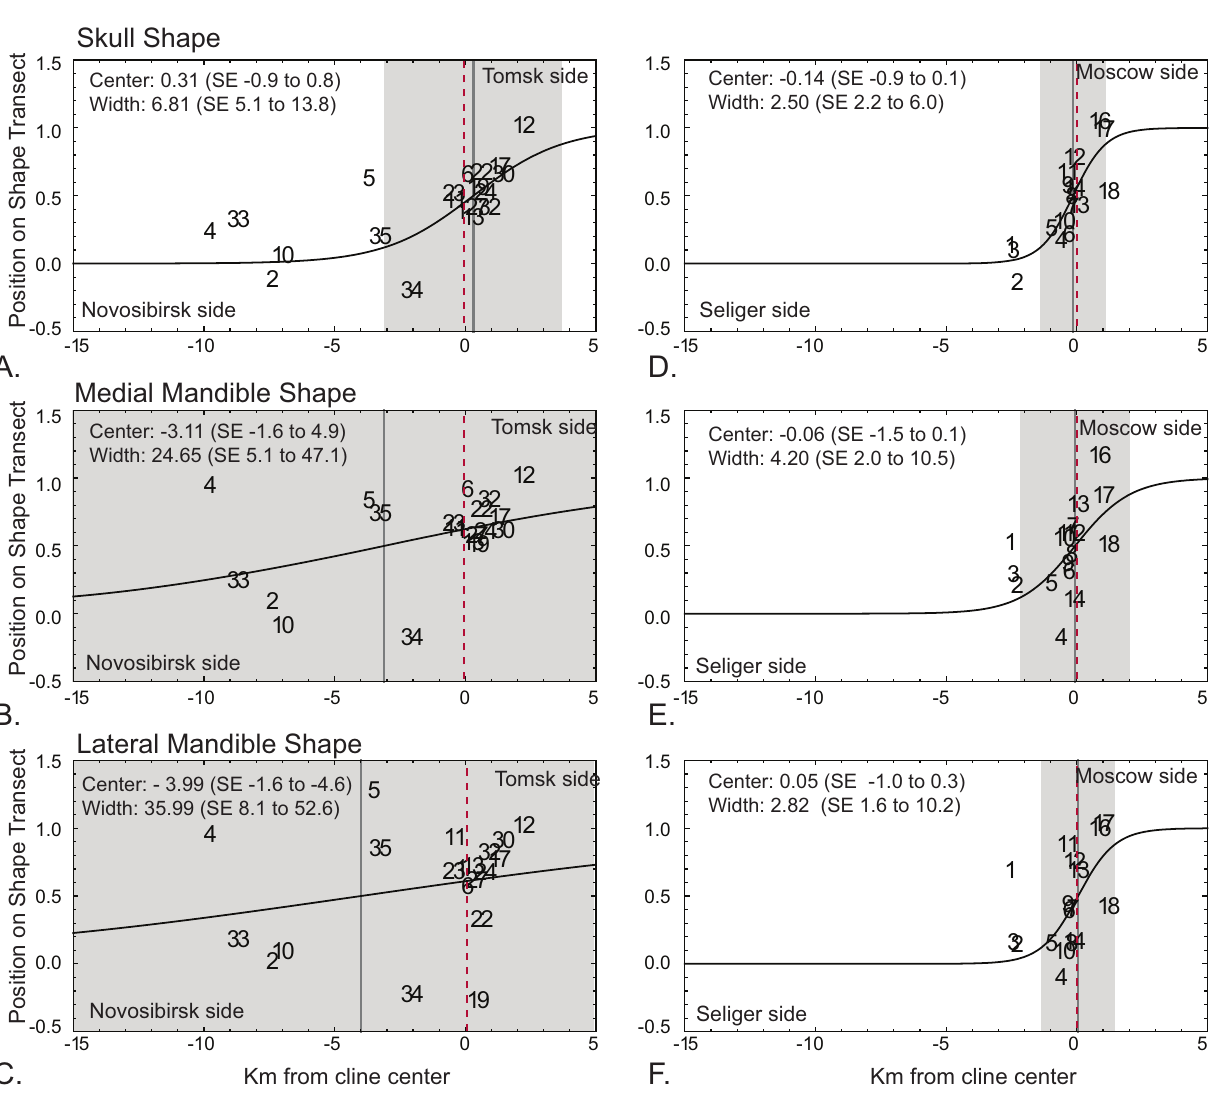
Figure 5. Phenotypic clines across the two hybrid zones. A–C. Novosibirsk-Tomsk hybrid zone. D–E. Moscow-Seliger hybrid zone. Horizontal axes show the distance in km from the center of the metacentric hybrid zone (Novosibirsk and Seliger distances shown as negatives) and vertical axes show the shape transects between the pure race samples (standardized with Novosibirsk and Seliger means equal to 0 and Tomsk and Moscow equal to 1). The center of the metacentric zone is highlighted with a dashed red line. The ML estimate of the phenotypic cline is shown in black, with its center marked by a vertical grey line and its width indicated by light grey shading. Data points are labeled using the locality numbering system in Figure 2 and Table S1.